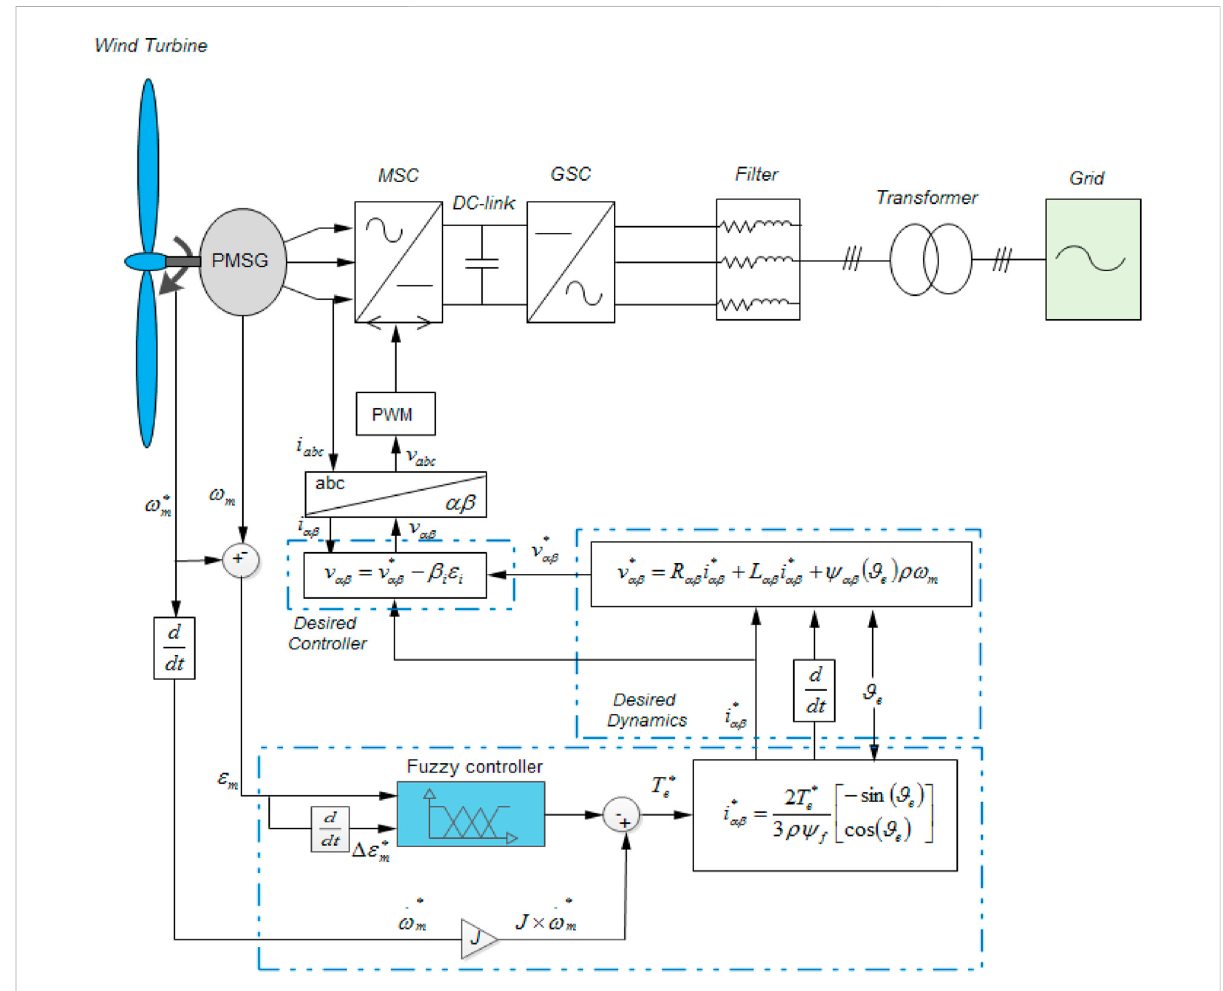
FIGURE 2 Schematic of the proposed